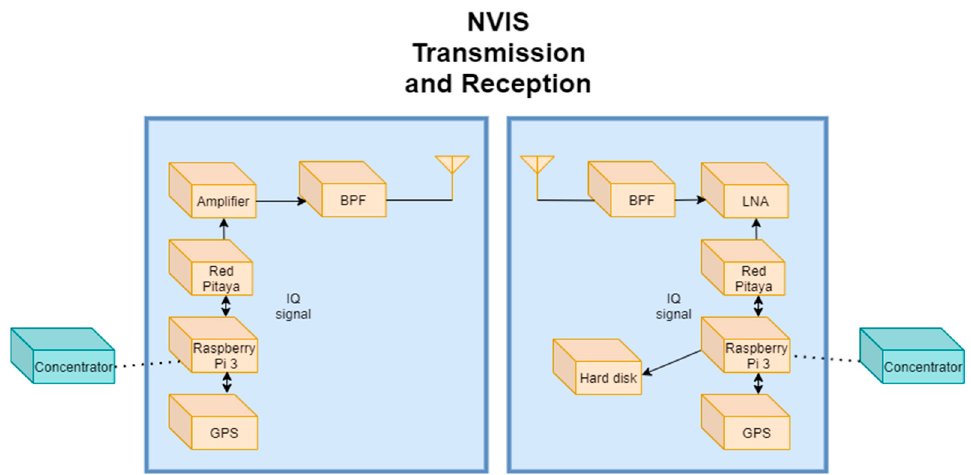
Figure 4. Near-vertical incidence skywave (NVIS) transmission scheme (transmitter on the left and receiver on the right).